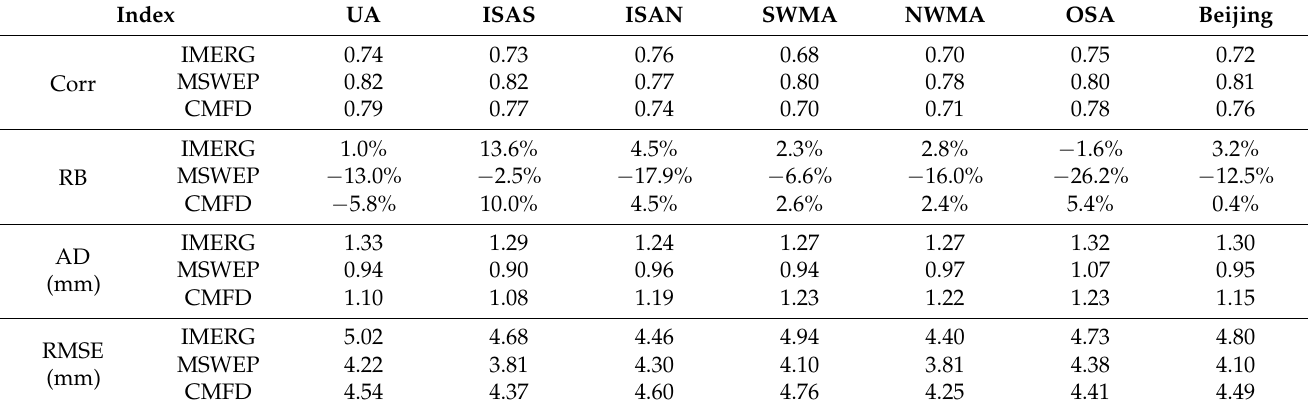
Table 5. Accuracy evaluation of the satellite-derived precipitation data in different subregions of